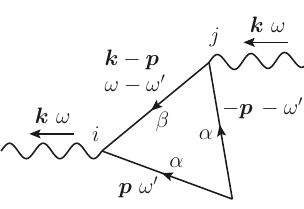
Figure 6 . Diagram for (cid:5)